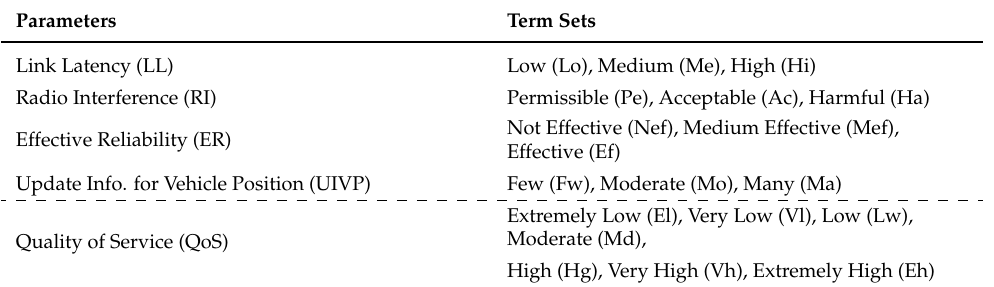
Table 1. Parameters and term sets for FS-AQoS.